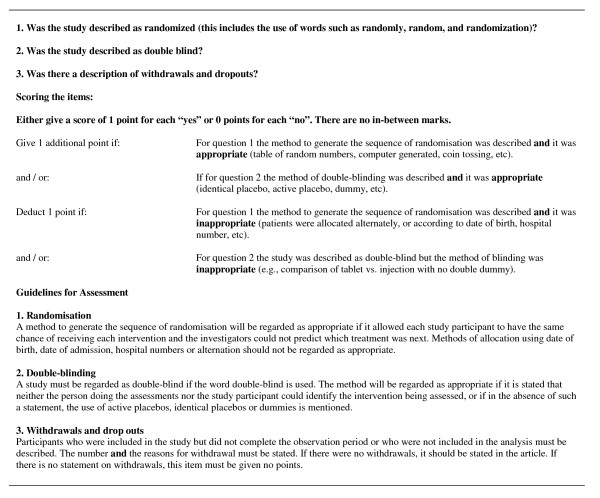
The Jadad scale.